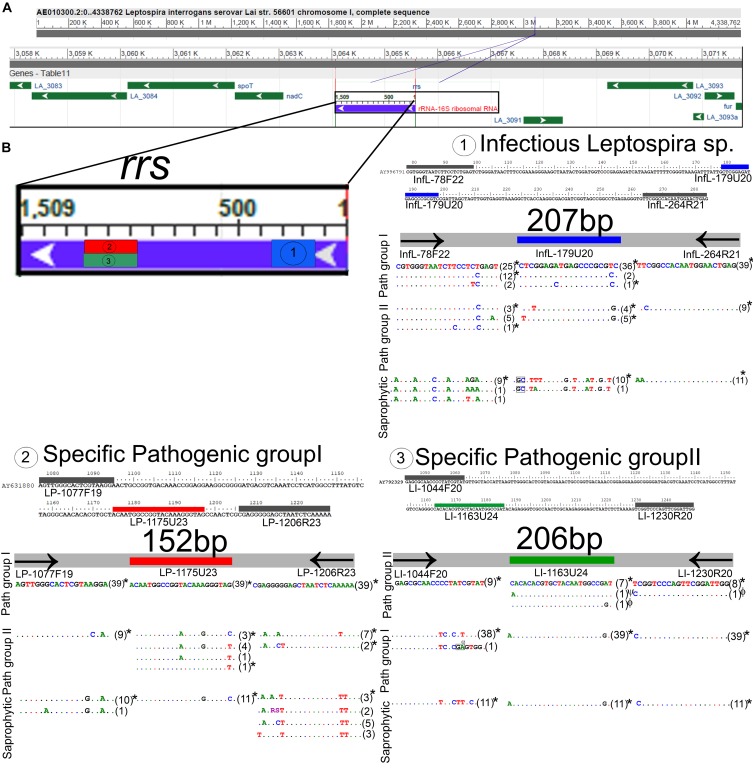
In silico analysis and locations of the target regions selected for the detection of Leptospira spp. (A) Whole genome representation of Leptospira spp., the targeted 16SRNA gene is denoted. (B) Location of the three target regions selected, the region targeted for the specific detection of infectious Leptospira spp. groups is denoted as 1 and highlighted in blue, the region targeted for the specific detection of pathogenic group I is denoted as 2 and highlighted in red, and the region targeted for the specific detection of pathogenic group I is denoted as 3 and highlighted in green; primer region analysis on all available sequences of Leptospira spp. (see Supplementary Table S1), for each target region the sequences of primers and probe are denoted, a total of 39 sequences for pathogenic group I, nine sequences for pathogenic group II and 11 sequences for saprophytic group were used. Dots indicate perfect match with the top sequence, letters indicate mismatches, insertions were denoted with black rectangles, all the polymorphisms tested using representative Leptospira spp. strains were denoted with an asterisk (∗), polymorphisms tested using genetic constructions were denoted with symbols (ψ,ϕ). The sizes for the amplicons of each target region are also denoted. The Whole-genome representation of Leptospira was used from the freely available NCBI source.